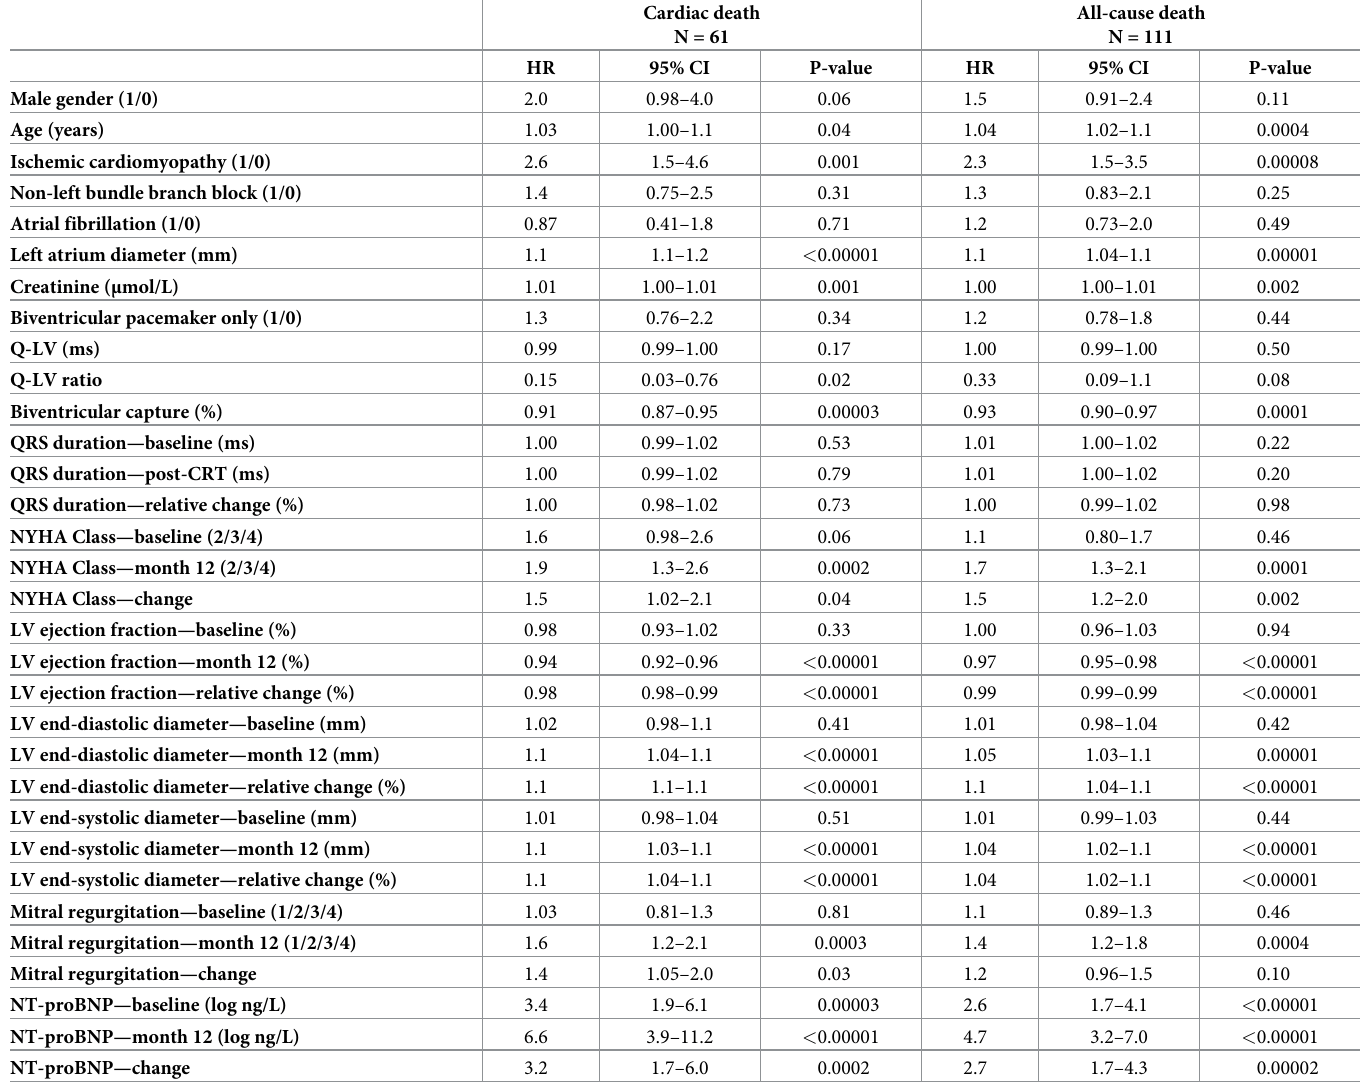
Table 3. Univariate association between individual factors and clinical events (cardiac and all-cause